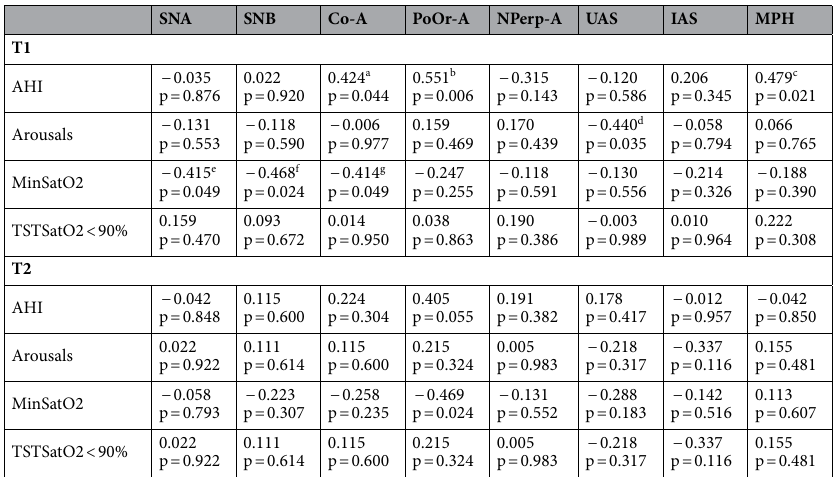
Table 8. Pearson’s correlations between AHI, Arousals, MinSatO2, TSTSatO2 < 90% and T1 and T2 cephalometric measures. MA. Online Supplementary Figures: a-Figure 8; b-Figure 9; c-Figure 10; d-Figure 11; e-Figure 12; f-Figure 13; g-Figure 14.